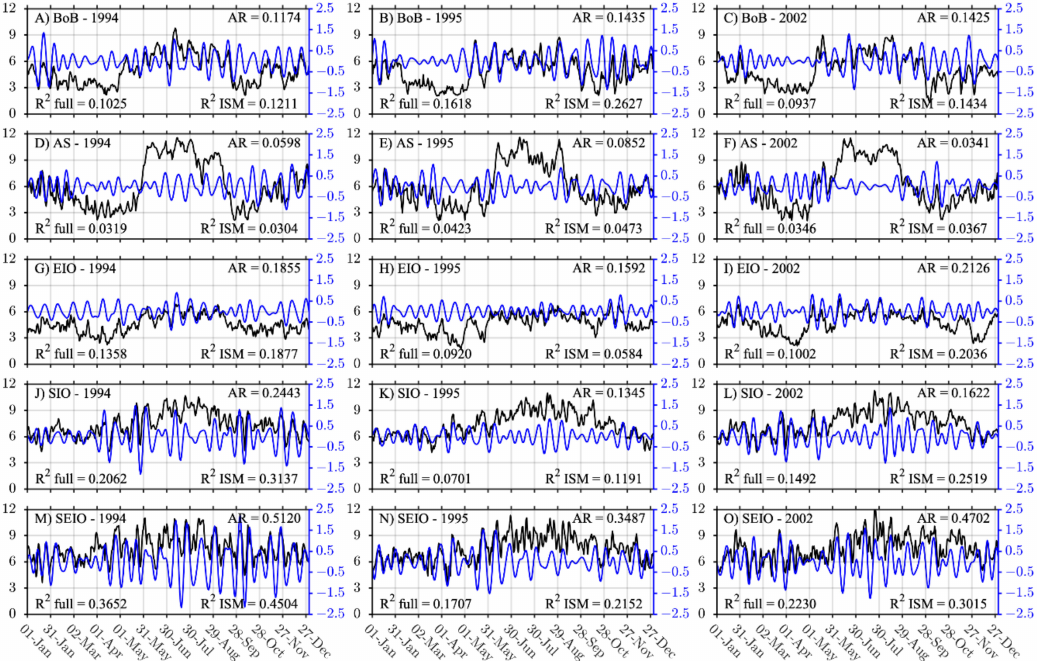
Figure 2. Unfiltered box averaged surface wind magnitude (black; m/s) over the Bay of Bengal (BoB; ( A – C )), Arabian Sea (AS; ( D – F )), equatorial Indian Ocean (EIO; ( G – I )), southern Indian Ocean (SIO; ( J – L )), and southeastern Indian Ocean (SEIO; ( M – O )) overlaid with 10–20-day bandpass-filtered time series of the same regions (blue; m/s) during 1994 (strong; left), 1995 (normal; middle), and 2002 (weak; right). R 2 values describe the variance explained by the 10–20-day mode for the full year (R 2 full) and during May–October (R 2 ISM). Amplitude ratio (AR) values are displayed in the upper left corner of each subplot and represent the ratio between the actual filtered portion of the signal compared to the overall signal for a given